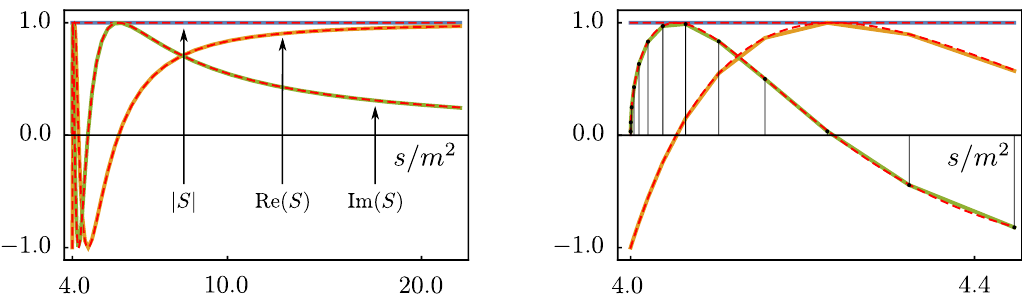
Figure 15 . Result of numerics for the spectrum M = 1 ; 1 : 6 ; 1 : 8 compared with the expecta- f g tion (3.2) and its near-threshold close-up (on the right). The green, orange and blue curves are Im( S num ), Re( S num ), S num where S num is (2.7) evaluated on the result of the numerics given j j in (A.3). The black dots indicate the points ( x n ; (cid:26) n ); note that we use a grid which clusters points near threshold. The dashed red curves are the corresponding parts of the exact solution